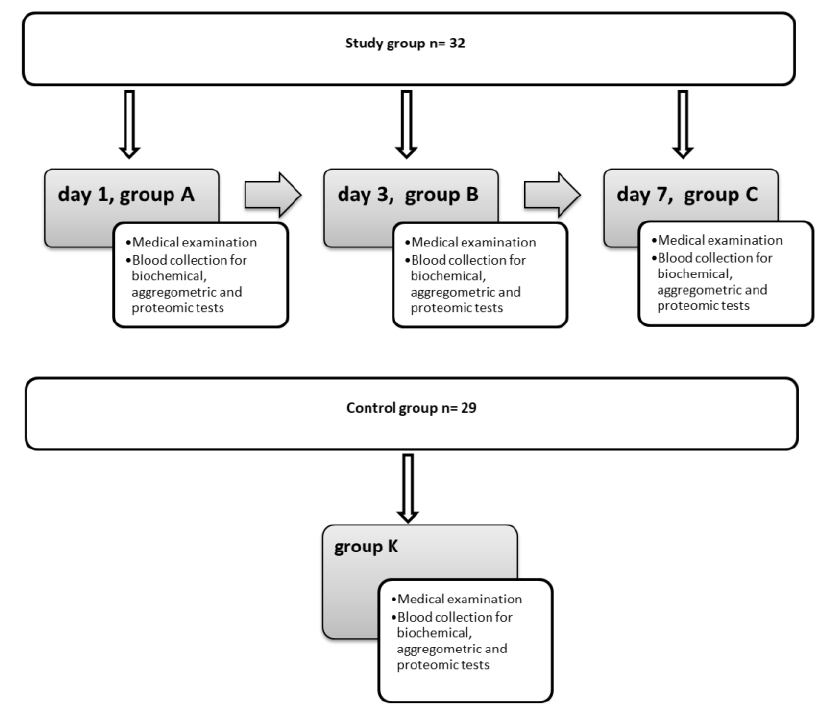
Figure 2. Study Figure 2. Study protocol.